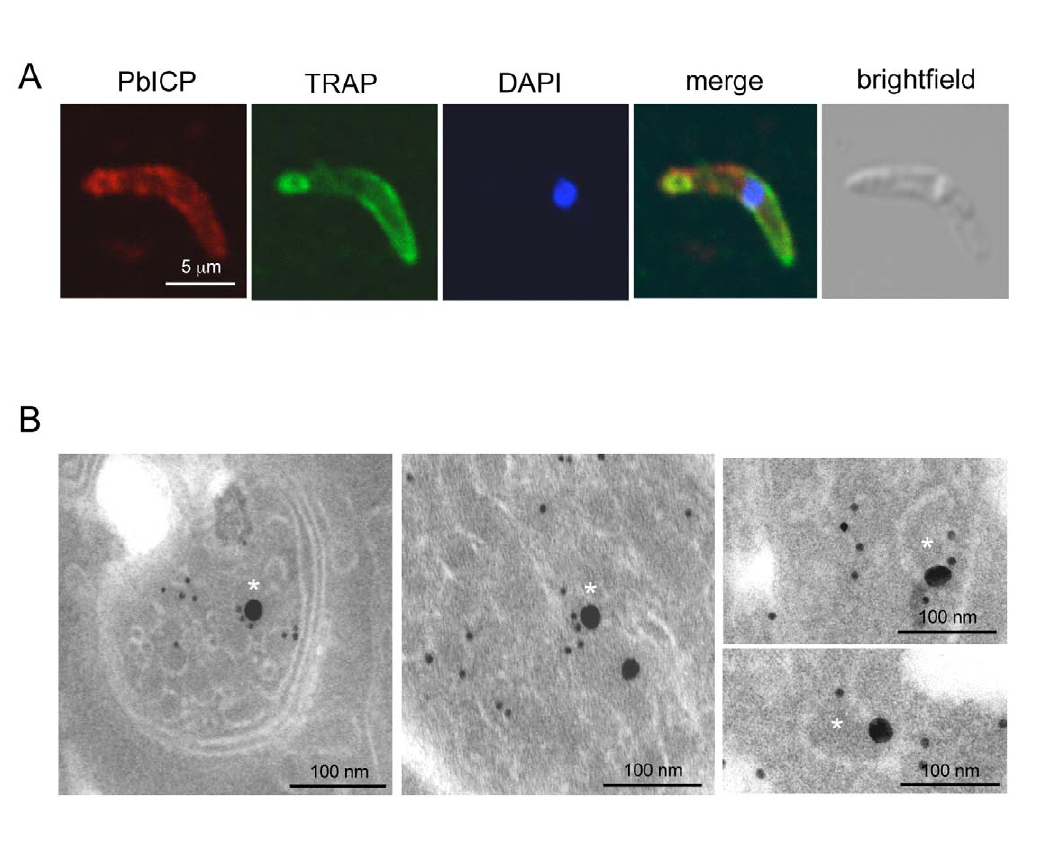
Figure 3. PbICP partially colocalizes with TRAP at the apical pole and in vesicles of sporozoites. ( A ) Confocal IFA of an extracellular P. berghei sporozoite in the presence of HepG2 cells. HepG2 cells were co-cultivated for 1 h with sporozoites, fixed and stained with an anti-TRAP antiserum (mouse, green) and a polyclonal antiserum against PbICP-C (rabbit, red). DNA was stained with DAPI (blue). ( B ) Double-stained IEM of a salivary gland sporozoite shows partial co-localization of TRAP and PbICP in vesicles (marked with asterisk). P. berghei -infected A. stephensi salivary glands were fixed 25 days after infection and prepared for IEM. Ultrathin sections were stained with PbICP-C (rabbit, 25 nm gold particles) and anti- TRAP (mouse, 10 nm gold particles). The sections were contrasted with uranyl acetate and lead